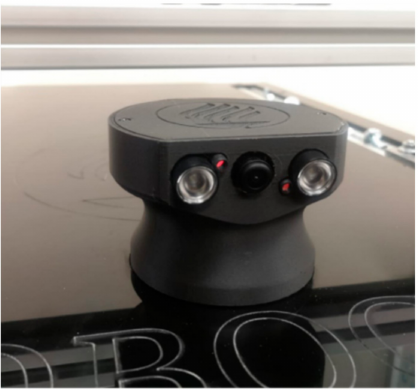
Figure 14. Onboard camera for the real-time video